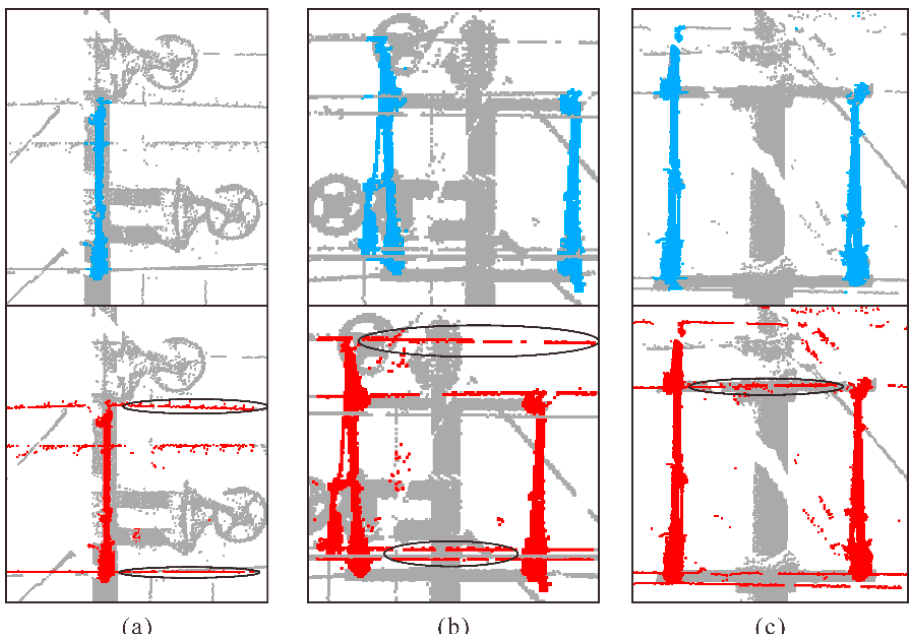
Figure 14. Differences in the extraction effects of the integrated PF, RC, and VPF filters and integrated PF and RC filters. Specifically, the blue results are the extractions of the integrated PF, RC, and VPF, and the red results are the extractions of the integrated PF and RC. ( a ) The application of the two filters on the SRSD. ( b ) The application of the two filters on the DRSD. ( c ) The application of the two filters on the SFSD.